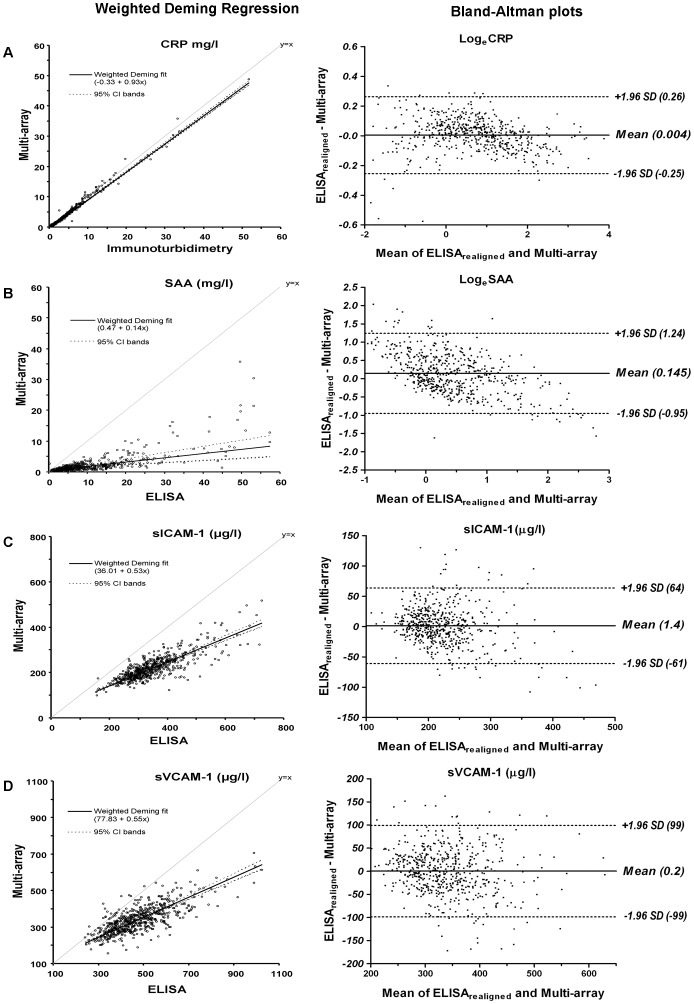
Left panel: comparison of biomarker concentrations between the single-biomarker techniques and the multi-array platform by weighted Deming regression; Right panel: Bland-Altman plots of the differences between the two methods.(A) CRP, C-reactive protein (n = 566); (B) SAA, serum amyloid A (n = 563); (C) sICAM-1, soluble intercellular adhesion molecule 1 (n = 566); and (D) sVCAM-1, soluble vascular cell adhesion molecule 1 (n = 567). For loge transformed data limits of agreement can be converted to original units by anti-log calculation (e.g., for CRP, e−0.25 and e0.26 which are equivalent to 0.78 and 1.30 times or 22% below or 30% above the long axis of CRP, respectively).